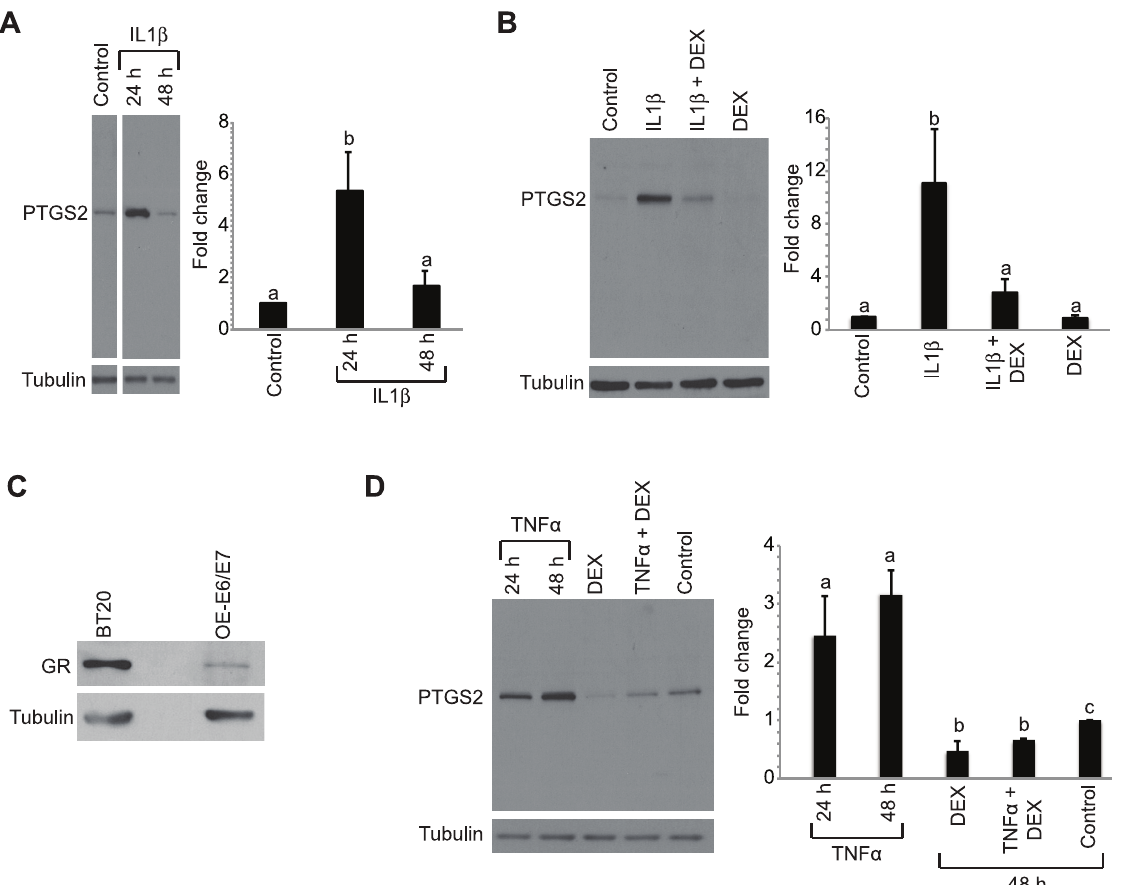
Figure 1. Increased PTGS2 levels in OE-E6/E7 cells by IL1 b and TNF a treatment is blocked by DEX. A, Cells were treated with 50 ng/ml IL1 b for 24 h or 48 h and Western blot analysis was performed for PTSG2 and tubulin. B, Cells were treated with 10 nM DEX or vehicle 30 h prior to treatment with IL1 b or vehicle and harvested 24 h later. Western blot analysis was performed for PTGS2 and tubulin. C, Western blot analysis was performed on OE-E6/E7 cells for glucocorticoid receptor and tubulin levels with BT20 breast cancer cells used as positive control. D, Cells were treated with DEX or vehicle 30 h prior to treatment with TNF a or vehicle. Cells treated with TNF a alone were harvested at 24 and 48 h after treatment and cells treated with DEX + TNF a were harvested at the 48 h time point. Western blot analysis was performed for PTGS2 and tubulin. Histograms summarize quantification of PTGS2 levels normalized to tubulin in 3 to 6 immunoblots. Bars represent the mean 6 SEM relative to control. Bars with different letters are statistically different from one another as determined by ANOVA followed by a Student-Newman-Keuls post-hoc multiple